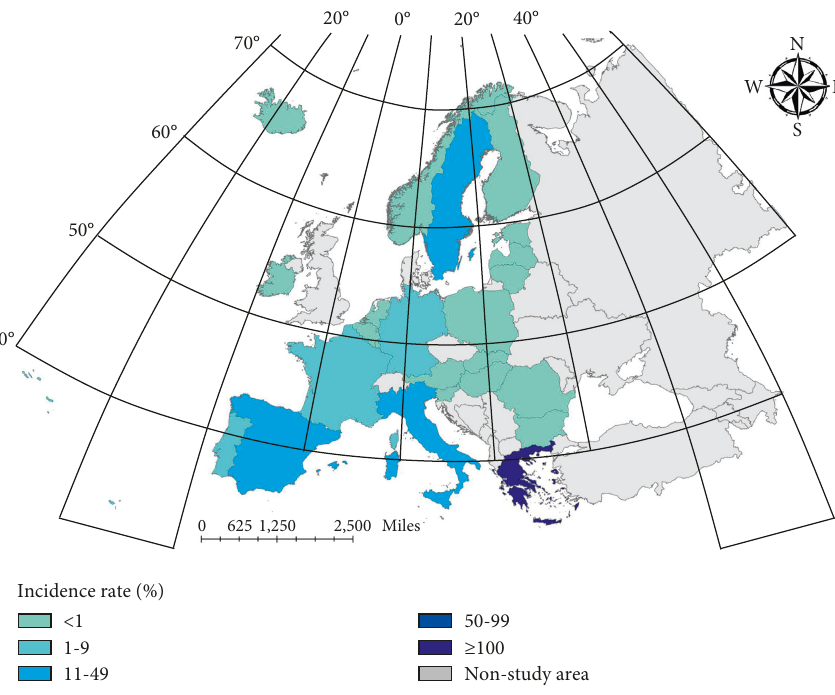
Figure 9: Spatial distribution of prediction data (ARIMA).